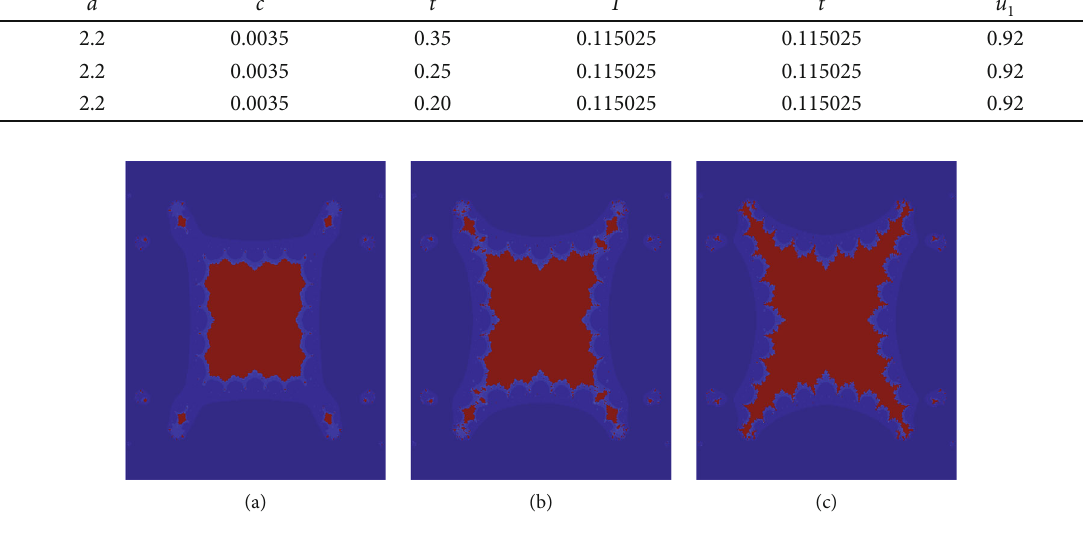
Figure 6: E ff ect of decrease in parameter t on quintic Julia set.